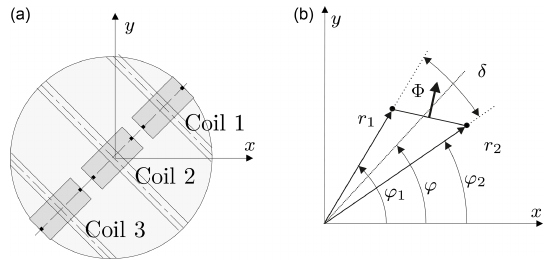
Figure 1. (a) Radial coil array. (b) Naming convention for angles and radii of a single-wire loop (Russenschuck,